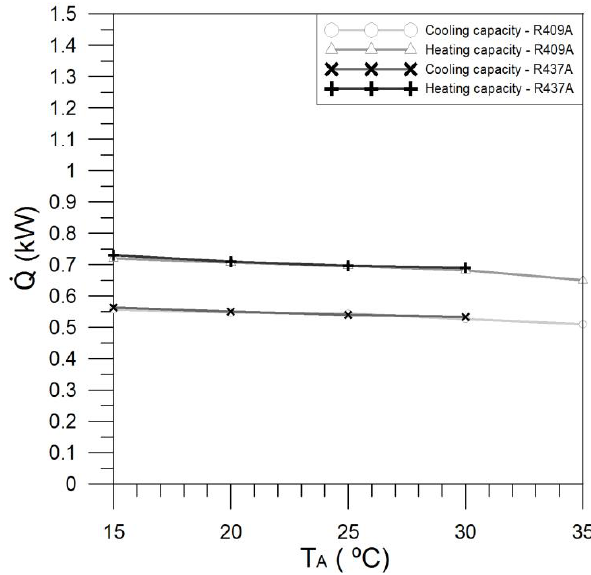
Figure 6: Effect of the heat source temperature on the compressor discharge temperature (Group A of tests).